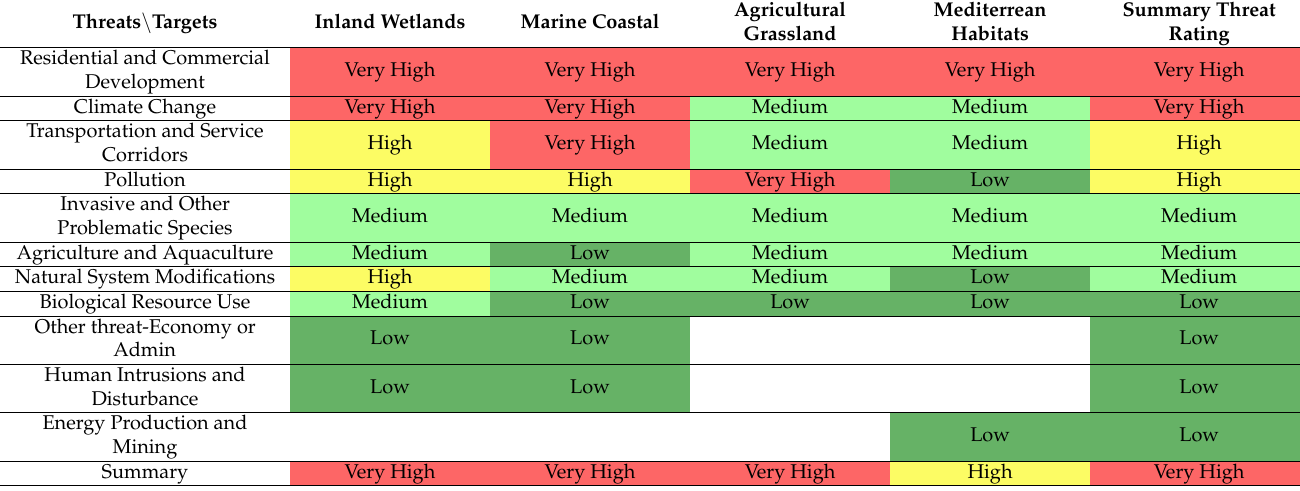
Table 3. Threat impacts ranking of key habitats of the Gediz Delta using the Conservation Standards Methodology. Threat impacts have been categorized as Low (Dark Green), Medium (Light Green), High (Yellow), Very High (Red), and not existing